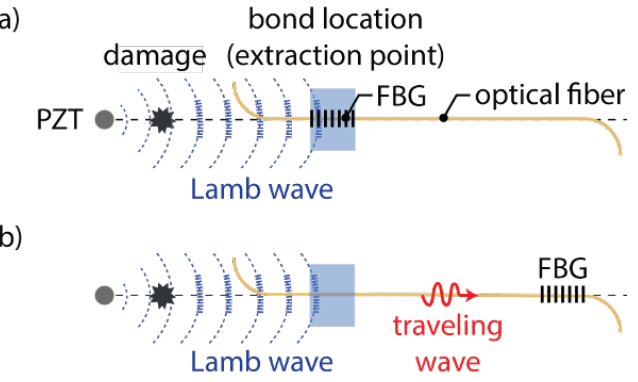
Figure 14. Ultrasonic signal measurement ( a ) at the extraction point (direct bonding) and ( b ) away from the extraction point using the FBG sensor (remote